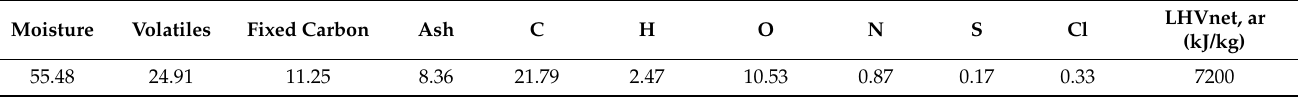
Table 1. Proximate and ultimate analyses (as received basis) of the MSW (wt%). Moisture Volatiles Fixed